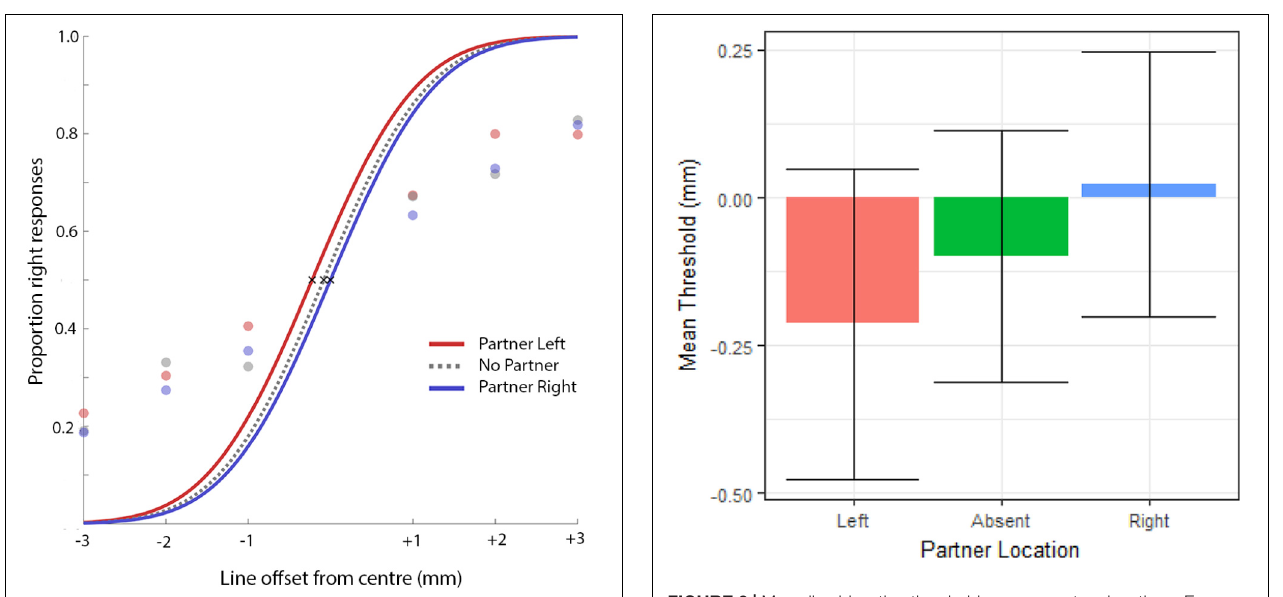
FIGURE 2 | Curves fitted to mean results from all thirty-one participants. Note that this is for illustrative purposes only and does not represent the inferential tests, which were performed on per-participant threshold values.